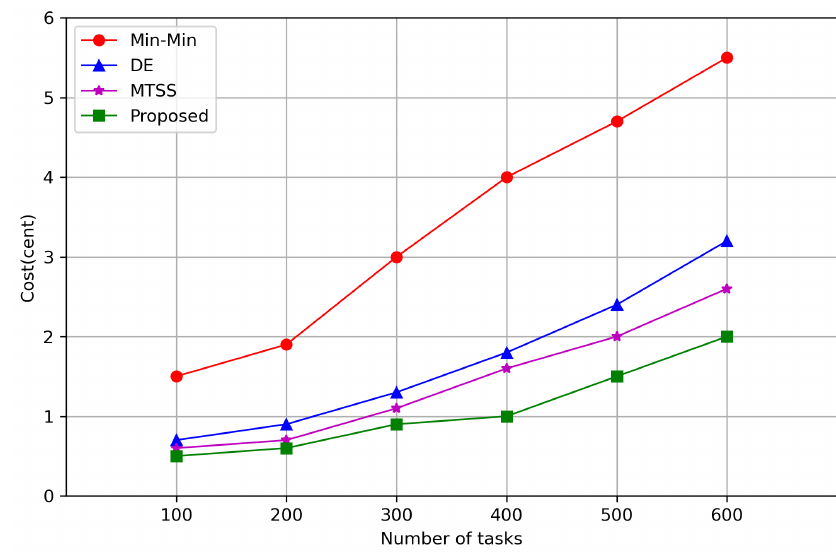
Figure 19. Performance evaluation of cost with number of tasks.